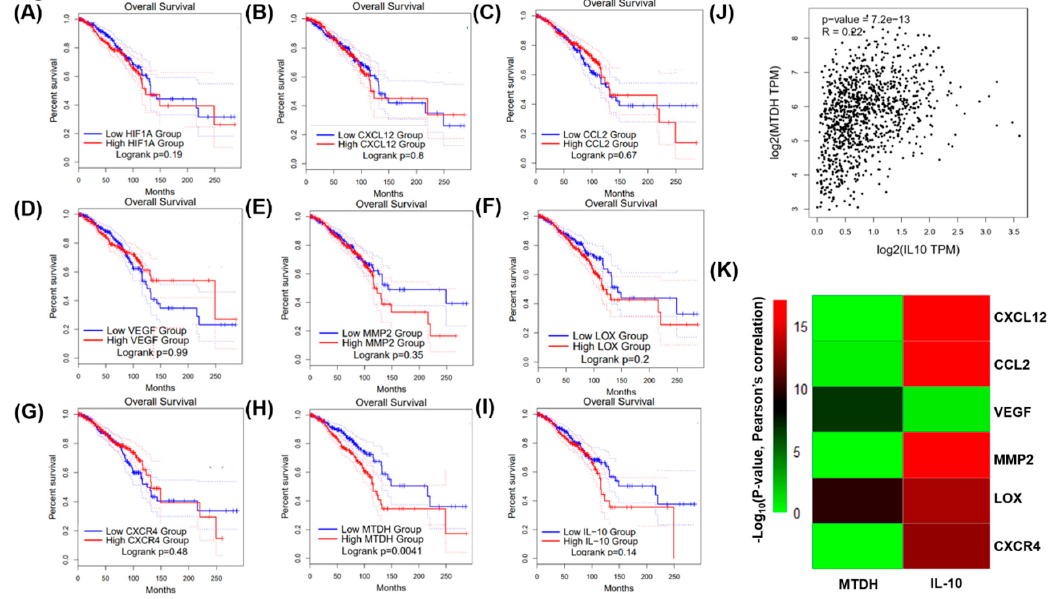
Figure 2. Clinical prognosis of breast cancer patients with the expressions of HIF ‐ 1 α and its target genes (MTDH, IL ‐ 10, CCL12, CCL2, VEGF, MMP2, LOX, and CXCR4) using the TCGA web server program. The Kaplan–Meier plot shows that lower expressions of HIF1 ‐α , MTDH ( H ), and IL ‐ 10 ( I ) were modestly associated with better overall survival of breast cancer patients. CXCL12, CCL2, VEGF, MMP2, and CXCR4 expression was not associated with overall survival of breast cancer patients. ( A– G ). ( J ) Pearson’s correlation elucidated a strong association between MTDH and IL ‐ 10 expression. ( K ) Heatmap of Pearson’s correlations, shown by calculating ( − Log10( p ‐ value))) for MTDH and IL ‐ 10 use with CXCL12, CCL2, VEGF, MMP2, LOX, and CXCR4.